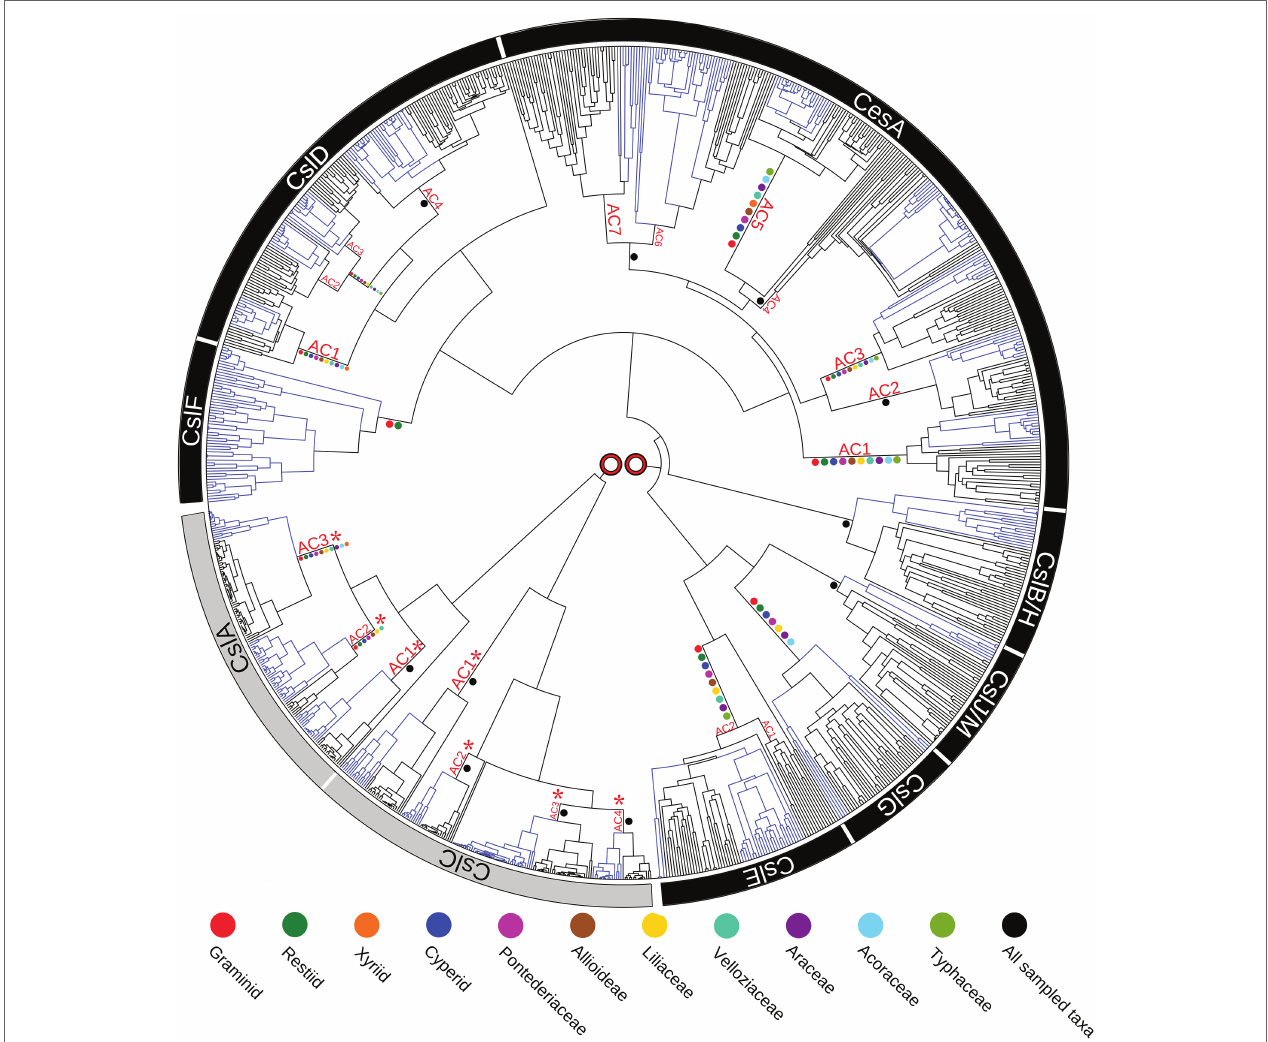
FIGURE 2 | Phylogenetic tree of the cellulose synthase gene superfamily constructed from species with fully sequenced genomes. Blue colored branches indicate monocots, while black branches indicate eudicots. Ancestral Clusters (AC) represent clades that existed before the monocot-eudicot divergence. Colored dots on nodes are from transcriptome data. No direct connection is shown between the two major evolutionary groupings ( CslA/CslC and CslF/CslA/CesA/CslB/H/CslJ/M/ CslG/CslE ), because it is likely that the family of genes originated from two separate endosymbiotic events. This figure is reproduced from Little et al.